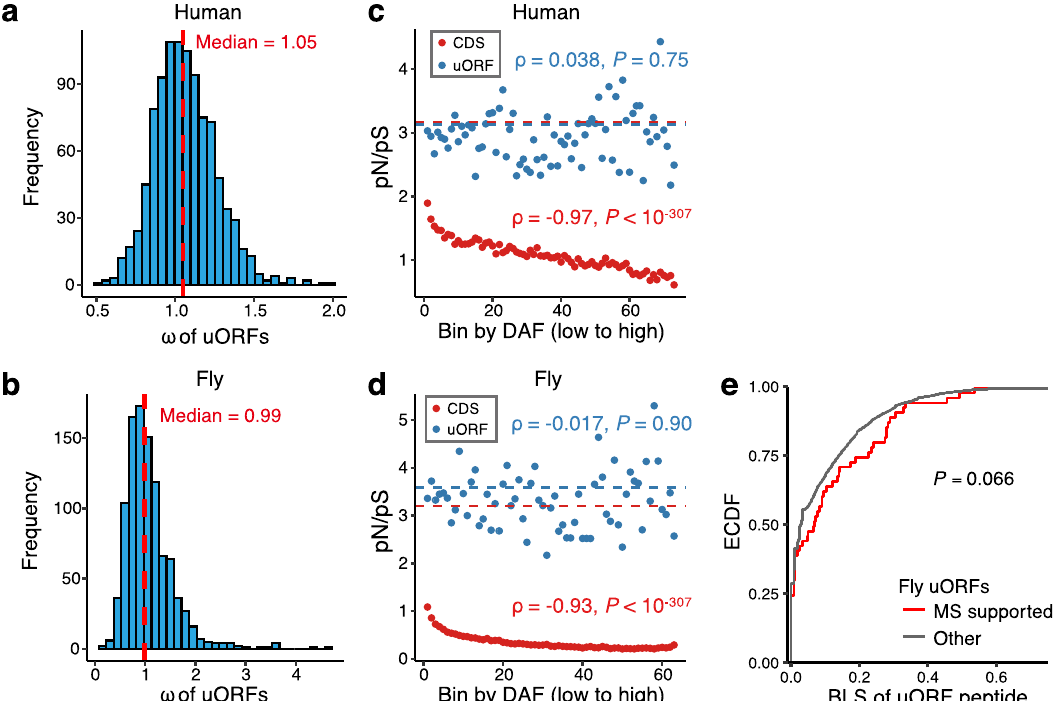
Fig. 5 Selective constraints on coding regions of upstream open reading frames (uORFs). a Distribution of the number of nonsynonymous changes per nonsynonymous site over the number of synonymous changes per synonymous site ( ω ) of uORFs between humans and rhesus macaques. Human uORFs were equally divided into 1000 bins based on the start codon of uORFs with an increasing Kozak score. For each bin, the alignments of uORF sequences between human and rhesus macaque were concatenated to calculate the ω value. b Distribution of the ω values of uORFs between D. melanogaster and D. simulans . The procedure for ω calculation was similar to that described in a . c The ratio of the nonsynonymous to synonymous SNP numbers ( pN / pS ) in coding sequences (CDSs, red) and uORFs (blue) in bins with an increasing derived allele frequency (DAF). Spearman ’ s correlation ( ρ ) between the pN / pS ratio and the median DAF of each bin of uORFs and CDSs is displayed in the plot with two-sided P values. d Same as c but for fl y uORFs. e The empirical cumulative distribution function of (ECDF) of peptide branch length score (BLS) for mass spectrometry (MS)-supported uORFs and the remaining uORFs in fl ies. uORFs with <10 amino acids were excluded. The one-sided t -test was performed to test differences in BLS. Source data are provided as a Source Data fi